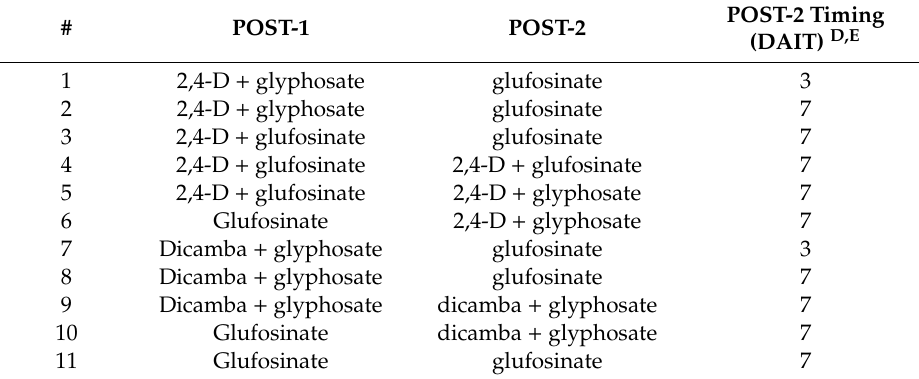
Table 1. Herbicide treatments used in field study A,B,C